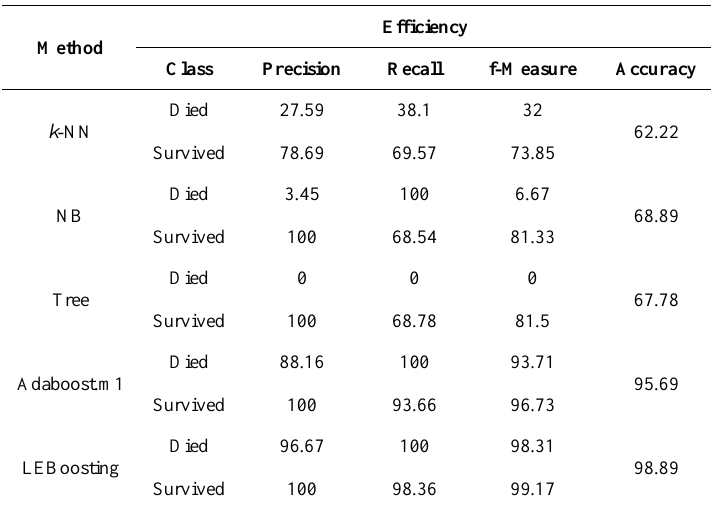
Table 4. Comparison of the efficiency of classification